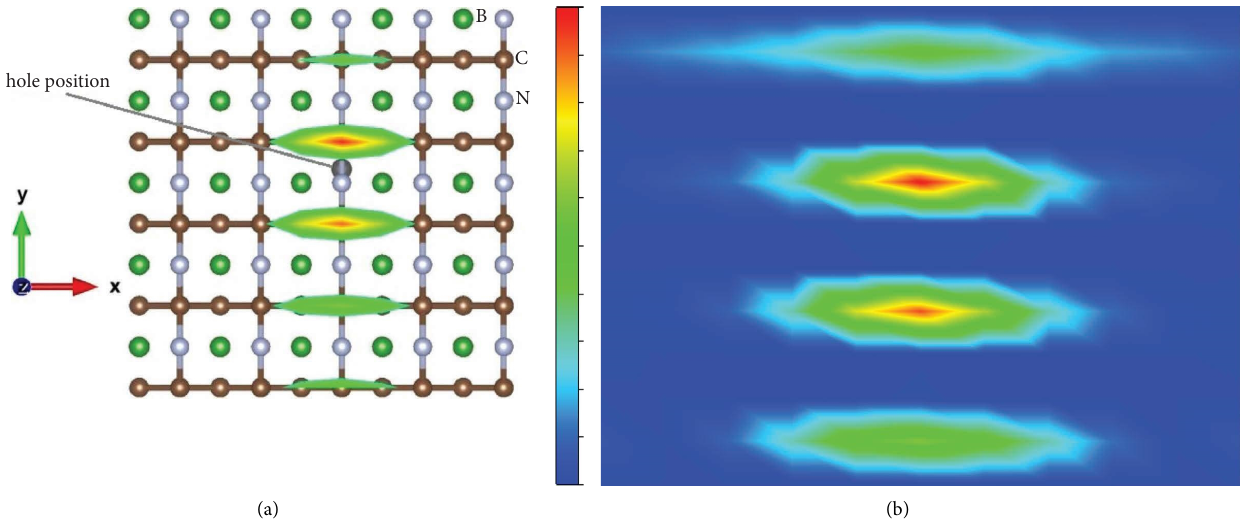
Figure 8: Exciton spatial distribution as the hole position fxed: (a) a top view of 5 × 5 × 1 supercells of o-BC representing boron (B), the brown color representing carbon (C), and light blue representing nitrogen (N) and (b) a two-dimensional contour plot of the probability density of fnding